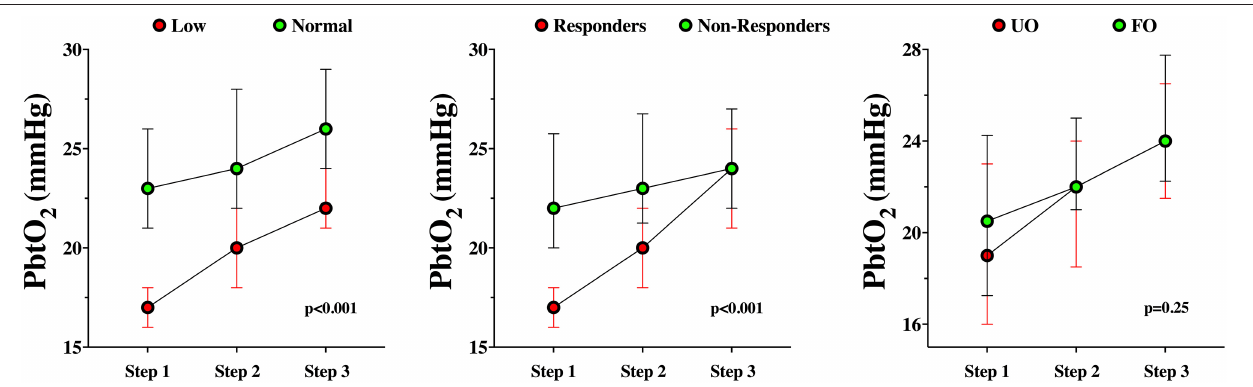
FIGURE 2 | PbtO 2 changes during the CPP challenge in responders and non-responders (left panel) , in baseline normal PbtO 2 values or tissue hypoxia (middle panel) or according to the neurological outcome (UO, unfavorable; FO, favorable – right panel ).